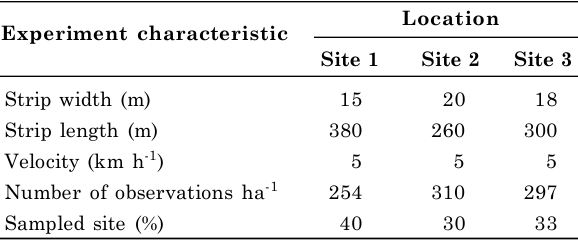
Table 1. Variable nitrogen fertilization rate based on the crop optical sensor applied at the phenological stage V8 of